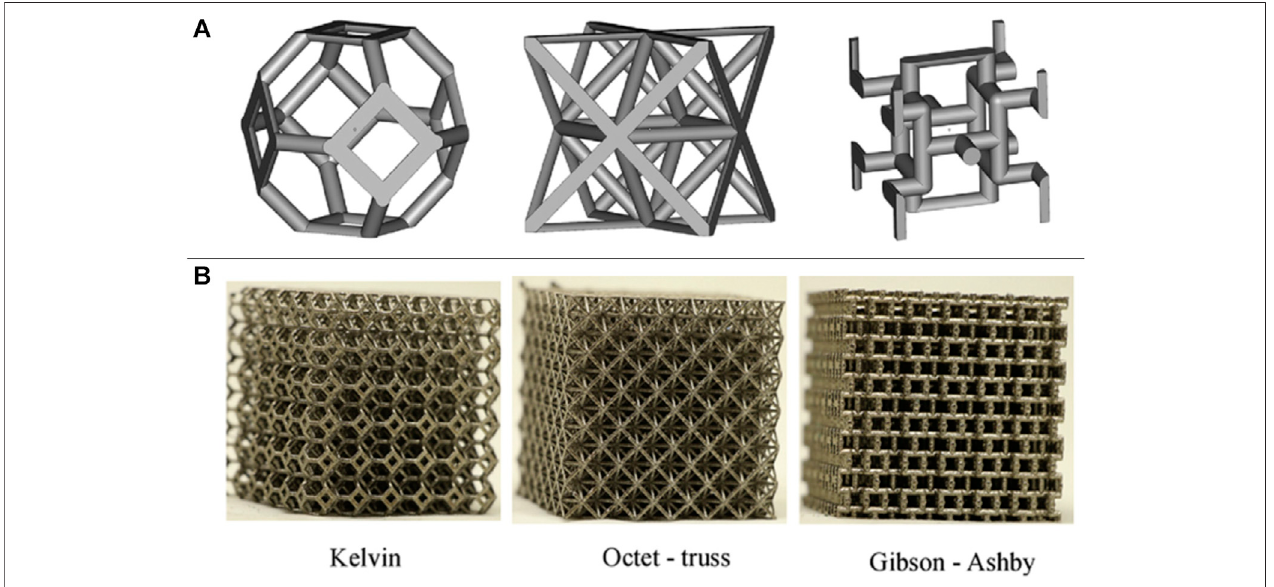
FIGURE 3 | Examples of different unit cells (A) and steel-based 3D printed (B) POCS based on the same unit cells (adapted from (Al-Ketan et al., 2018))